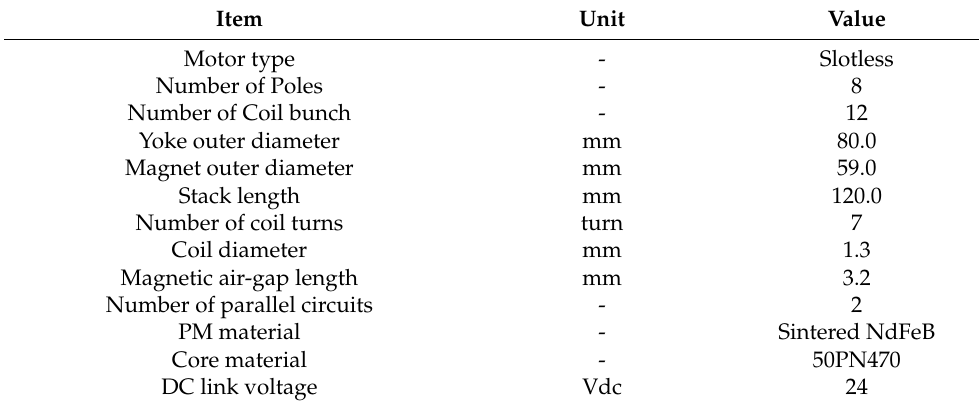
Table 4. Prototype specification.